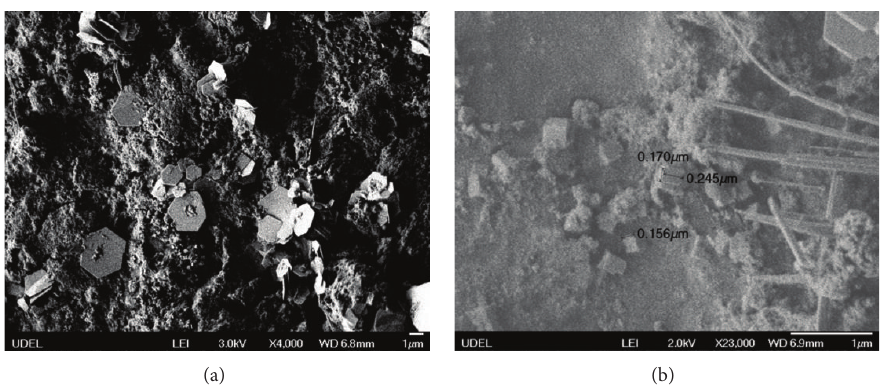
Figure 2: pH value on the influence of the PZT nanocrystalline morphology (a) pH = 8 ; (b) pH = 13 .